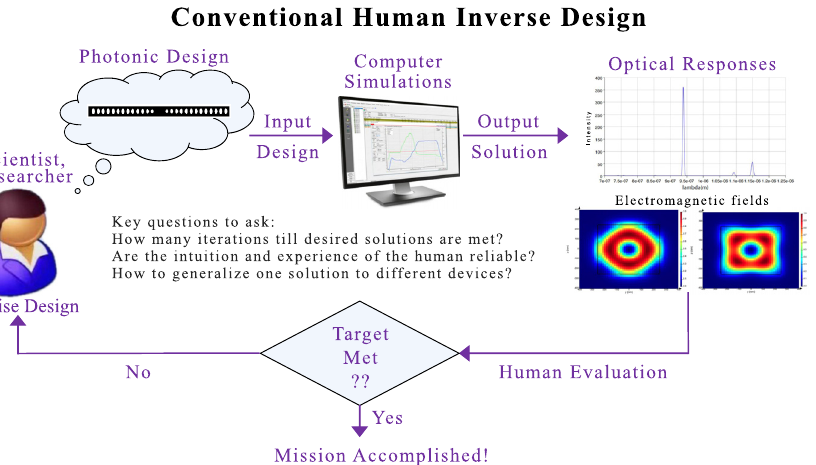
Figure 2: Comparison between deep RL-enabled (this work) and conventional human-centered inverse design methodologies. (a) Full details of the deep RL-based implementation of L2DO for photonics inverse design. L2DO takes in the desired optical specifications of certain photonic devices and delivers the solved design parameters. Both DQN and PPO algorithms are seamlessly incorporated within L2DO. The policy (RL agent) is implemented with a 4-layer MLP network whereas the environment is realized by an FDTD-based simulation solver (or optionally a DNN). Data sequences are stored in a replay buffer for data sample reuse and breaking sample correlations. (b) Human-centered iterative inverse design approach, which is still the most common practice in existence today. This conventional approach, relying on the intuition and experience of the human expert, typically takes over a month or even months to yield a satisfactory photonic